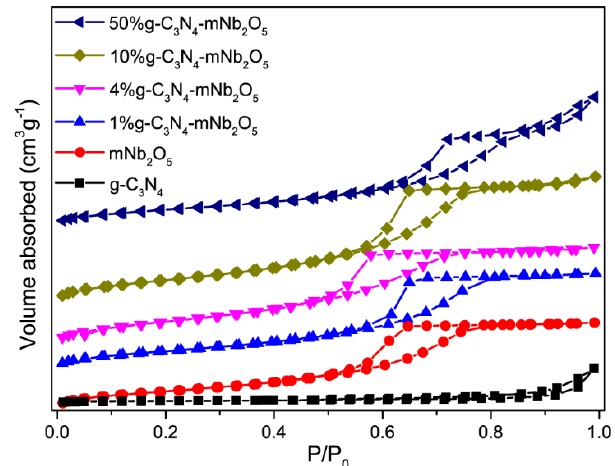
Figure 4. Nitrogen adsorption–desorption isotherms of g-C 3 N 4 , mNb 2 O 5 , 1% g-C 3 N 4 -mNb 2 O 5 , 4% g-C 3 N 4 -mNb 2 O 5 , 10% g-C 3 N 4 -mNb 2 O 5 and 50% g-C 3 N 4 -mNb 2 O 5 .